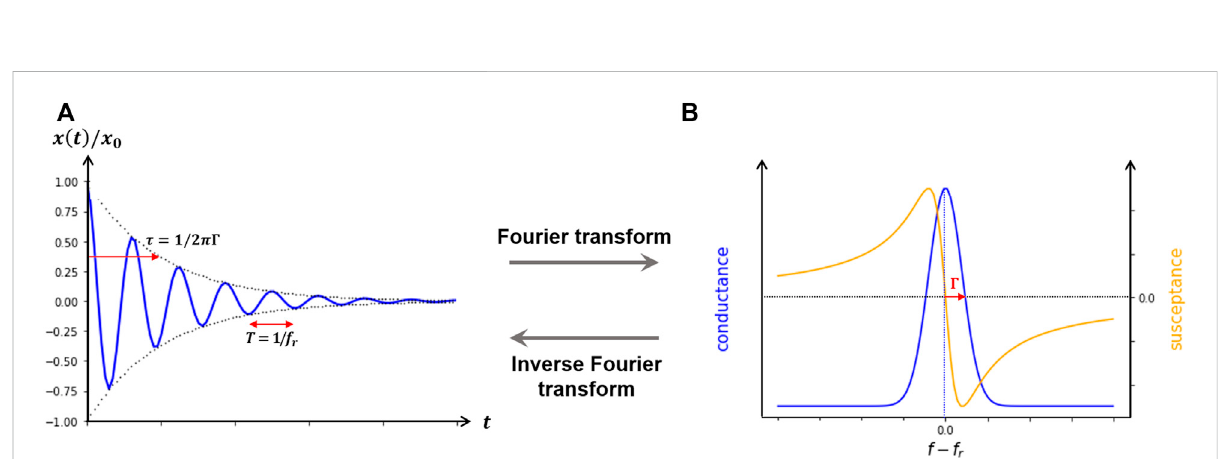
Modesofdetectingresonantphenomena. (A) ,ring-downmethod,wherethedrivingsignalisabruptlyshutoffthedecayasacurrenttraceonan oscilloscope is observed. (B) , impedance analysis in which one may either sweep the frequency of an AC excitation across the